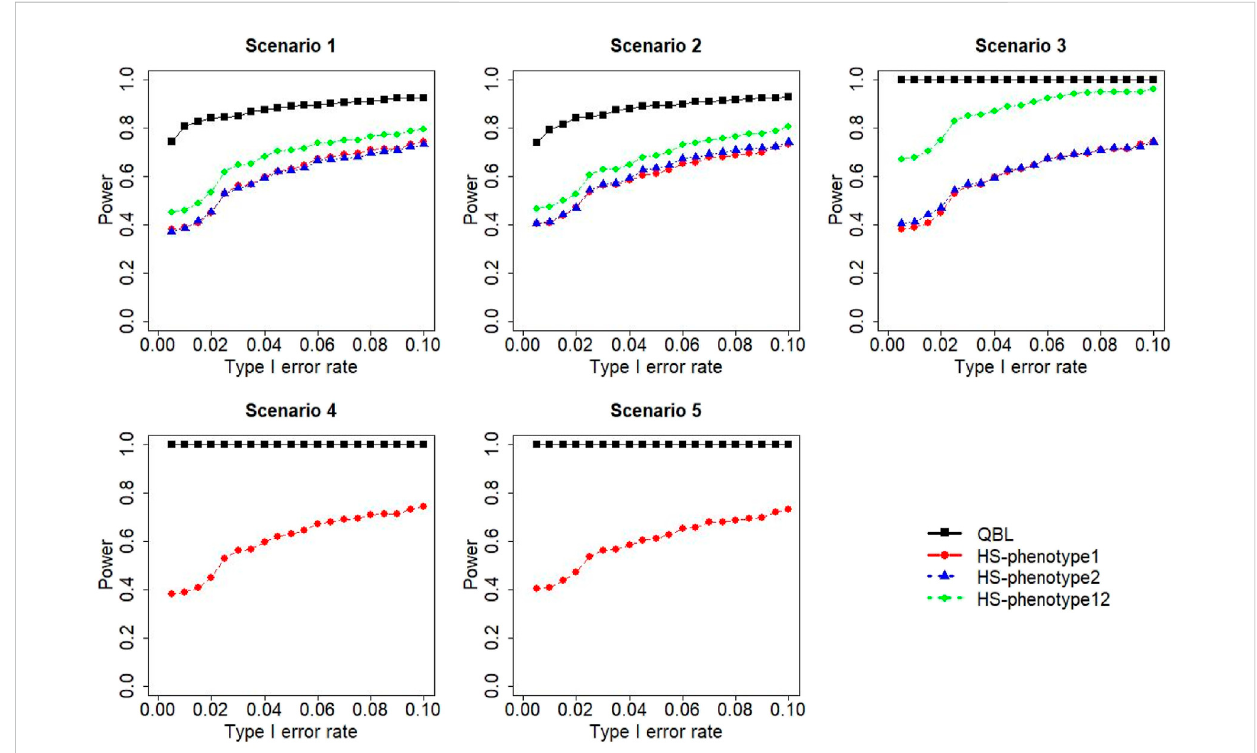
FIGURE 12 Simulation results under sample size 1,000, setting 2 (12 haplotypes), and ρ = 0.9. Scenarios are shown in Table 1. HS, Haplo.score; phenotype12, phenotype 1 or 2.